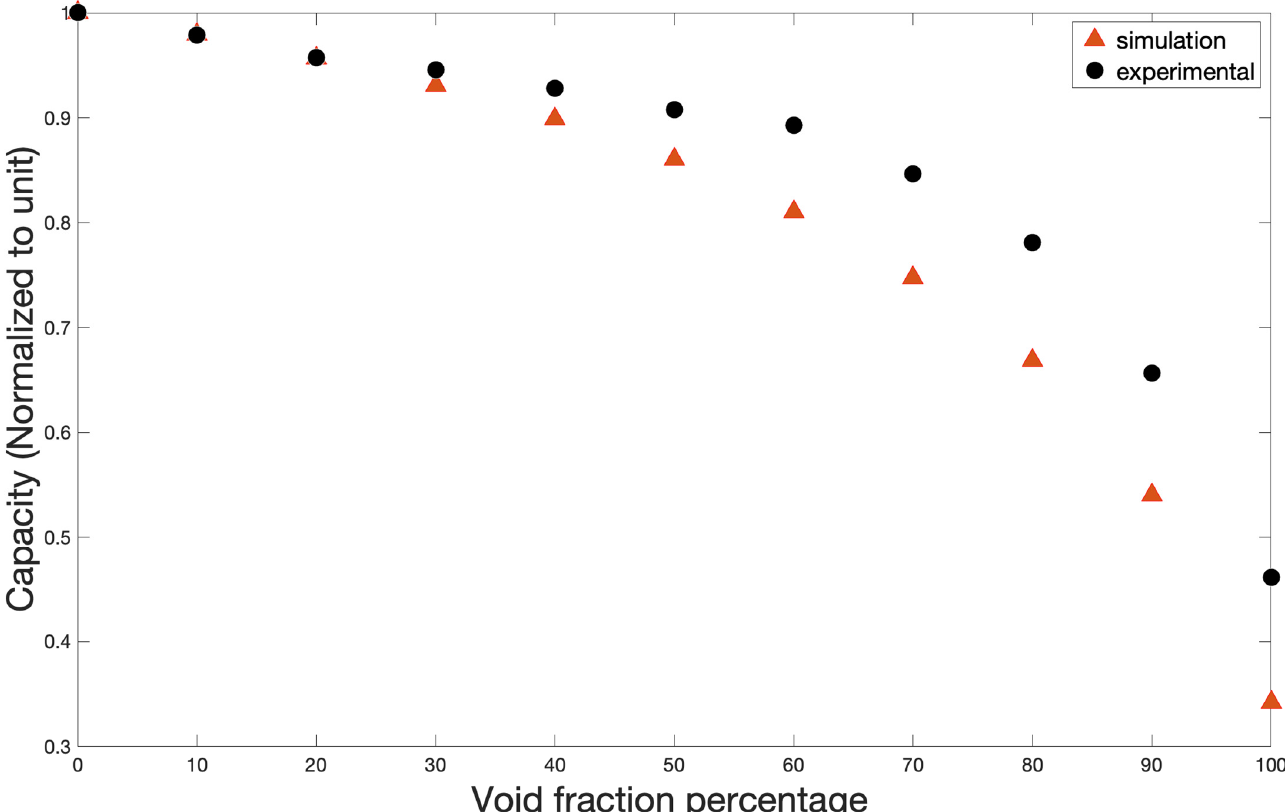
Figure 11. Comparison of the experimental data and the simulated data in a two-phase annular